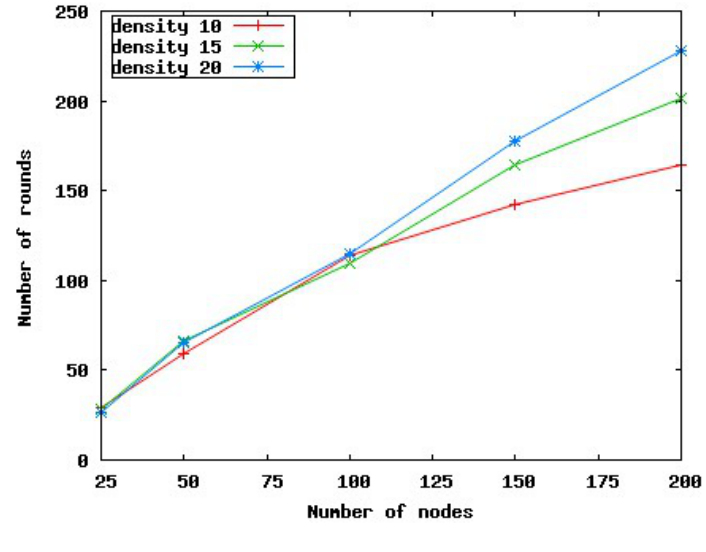
Figure 10. Number of rounds used by SERENA for different network configurations.